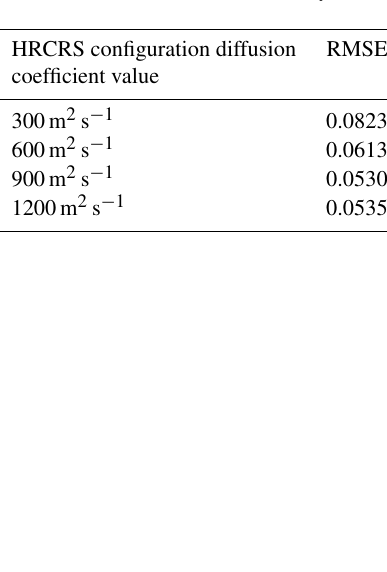
Table A1. RMSE with the HR solution after 1 year of simulation.